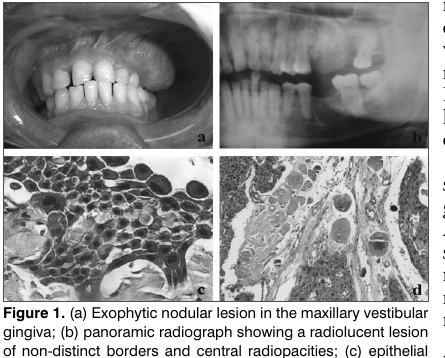
Figure 1. (a) Exophytic nodular lesion in the maxillary vestibular gingiva; (b) panoramic radiograph showing a radiolucent lesion of non-distinct borders and central radiopacities; (c) epithelial polyhedral cell islands with pleomorphism and prominent inter- cellular bridges (HE/ 400x); (d) concentric lamellar calcifications among epithelial polyhedral cell islands (HE/